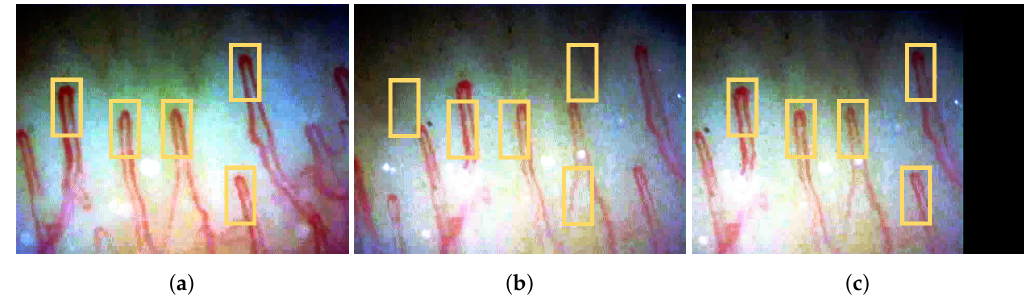
Figure 5. Example of the video stabilization process: ( a ) the first frame set as a reference, ( b ) a frame before the stabilization, and ( c ) a frame stabilized based on the reference. The yellow rectangles indicate the initial position of capillaries in the reference frame. Note the shift of the frame after the stabilization process.